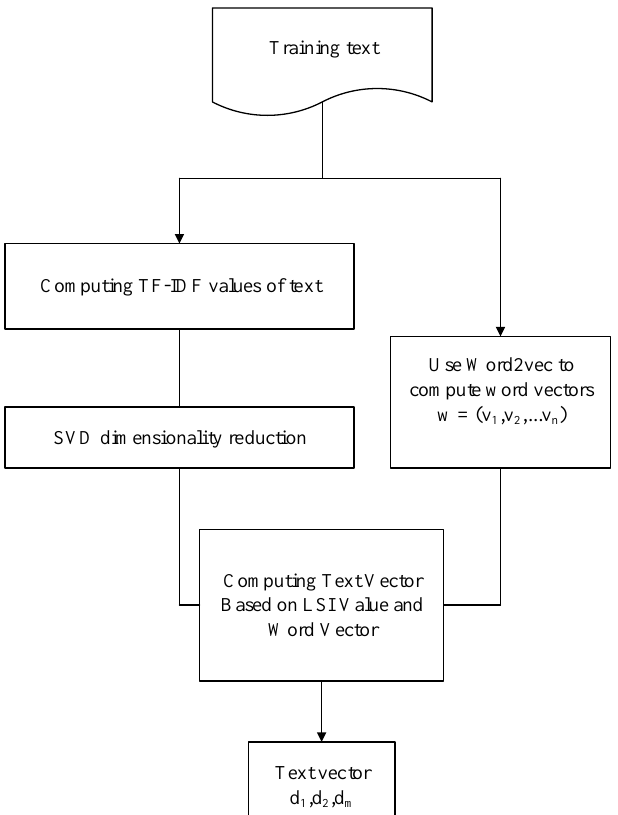
Figure 3. Feature extraction. TF-IDF, Term Frequency-Inverse Document Frequency.